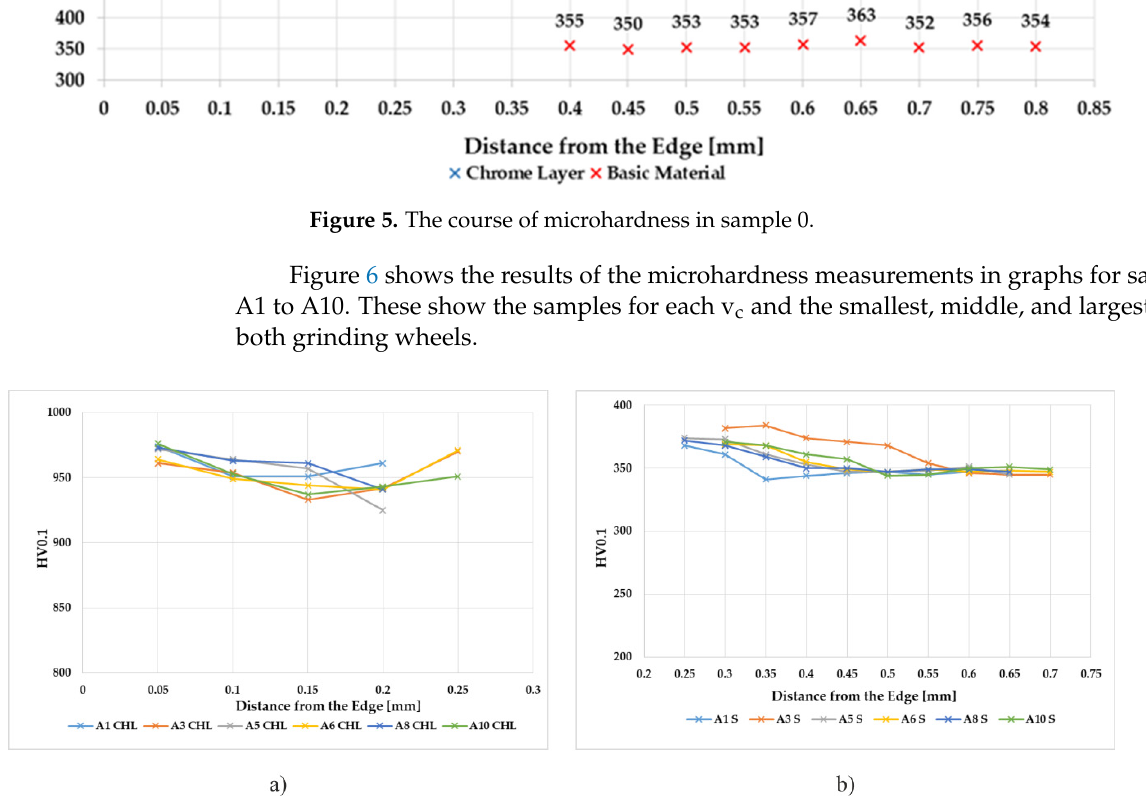
Figure 6. The course of microhardness in samples A1 to A10, ( a ) microhardness in the chrome layer, CHL = chrome layer; ( b ) microhardness in the substrate, S = substrate.